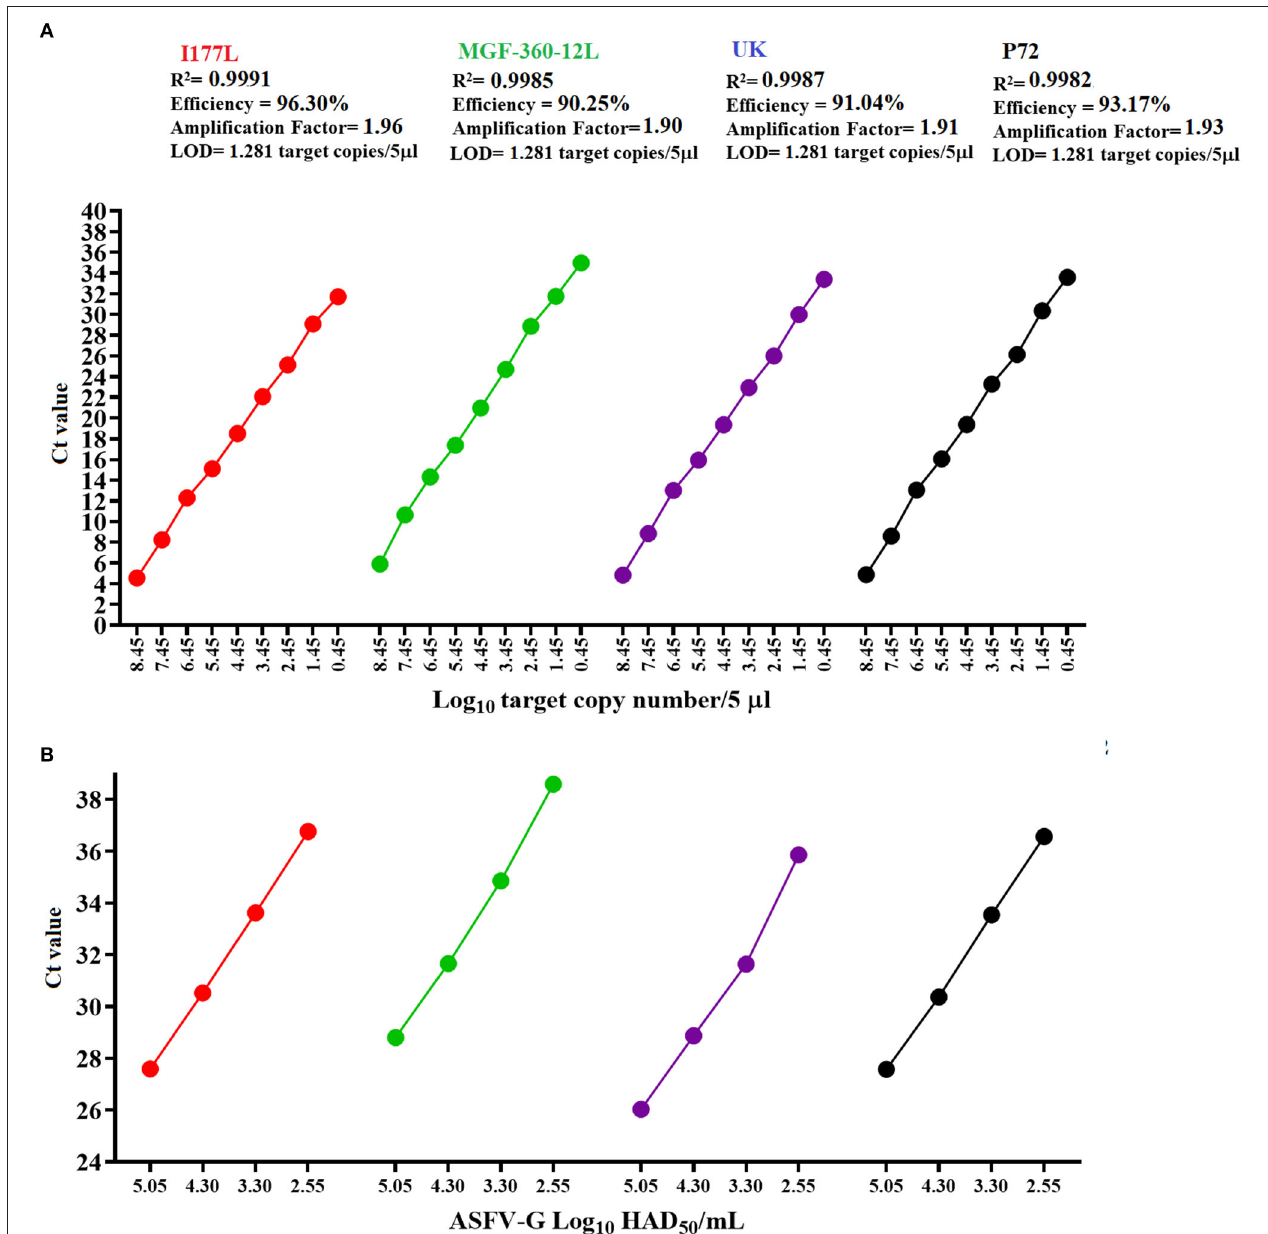
FIGURE 3 | Amplification efficiency and analytical sensitivity determinations. (A) Ten-fold dilutions of a standard plasmid representing variable amounts of all gene targets were used to calculate the amplification efficiency and analytical sensitivity of multiple qPCRs. (B) Ten-fold dilutions of a stock of ASFV-G with a known titer was used to establish parameters of analytical sensitivity in terms of the capability of different qPCRs to detect minimal amounts of infectious ASFV. Amount of infectious virus is expressed as HAD 50 /mL units. In all cases results represent the average value of six replicates.